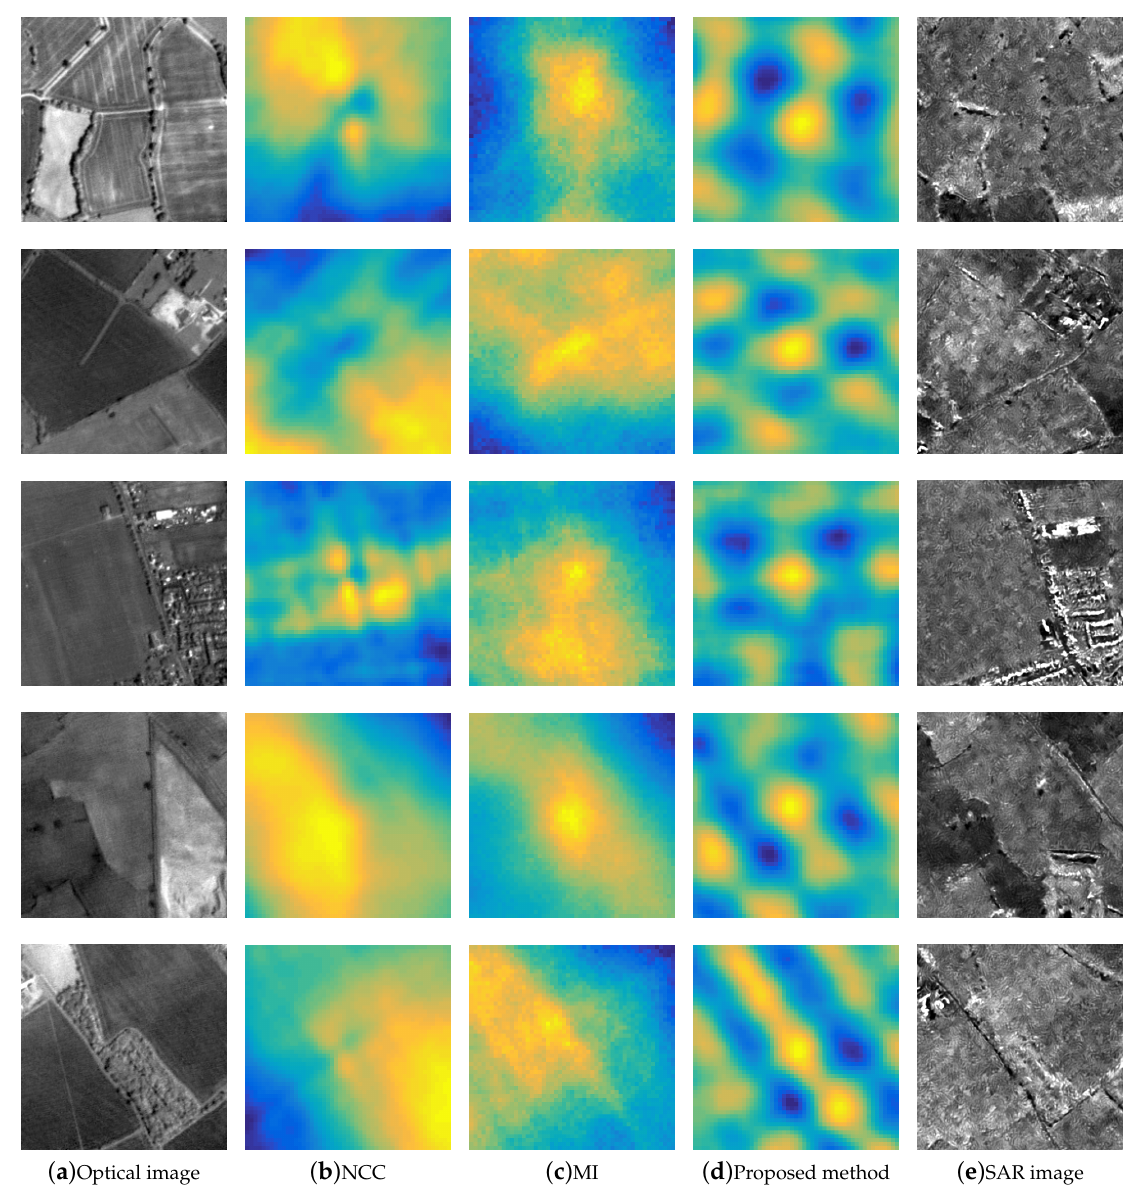
Figure 6. Side by side comparison between ( a ) optical patches (201 of NCC, ( c ) MI, and ( d ) our method (51 (251 251 ×